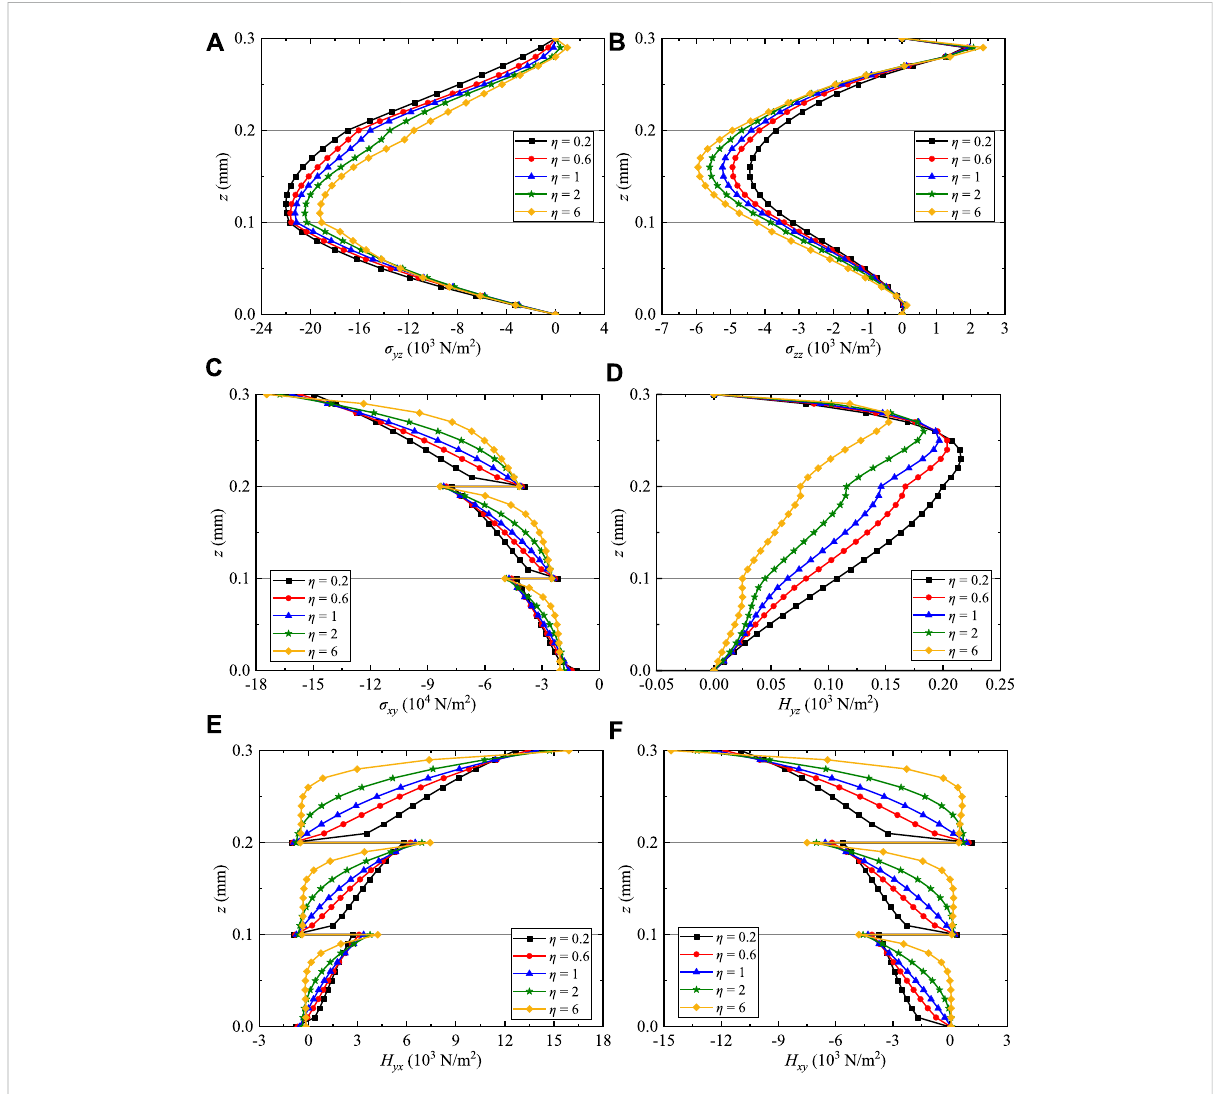
FIGURE 4 Variation of the phonon and phason stresses for QC coating structures: (A) σ yz , (B) σ zz , (C) σ xy , (D) H yz , (E) H yx , and (F) H xy .